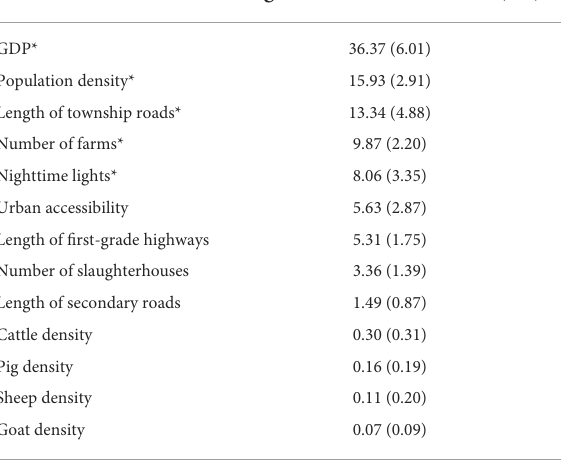
TABLE 4 Summary of average relative contributions (%) of predictor variables in the BRT models.